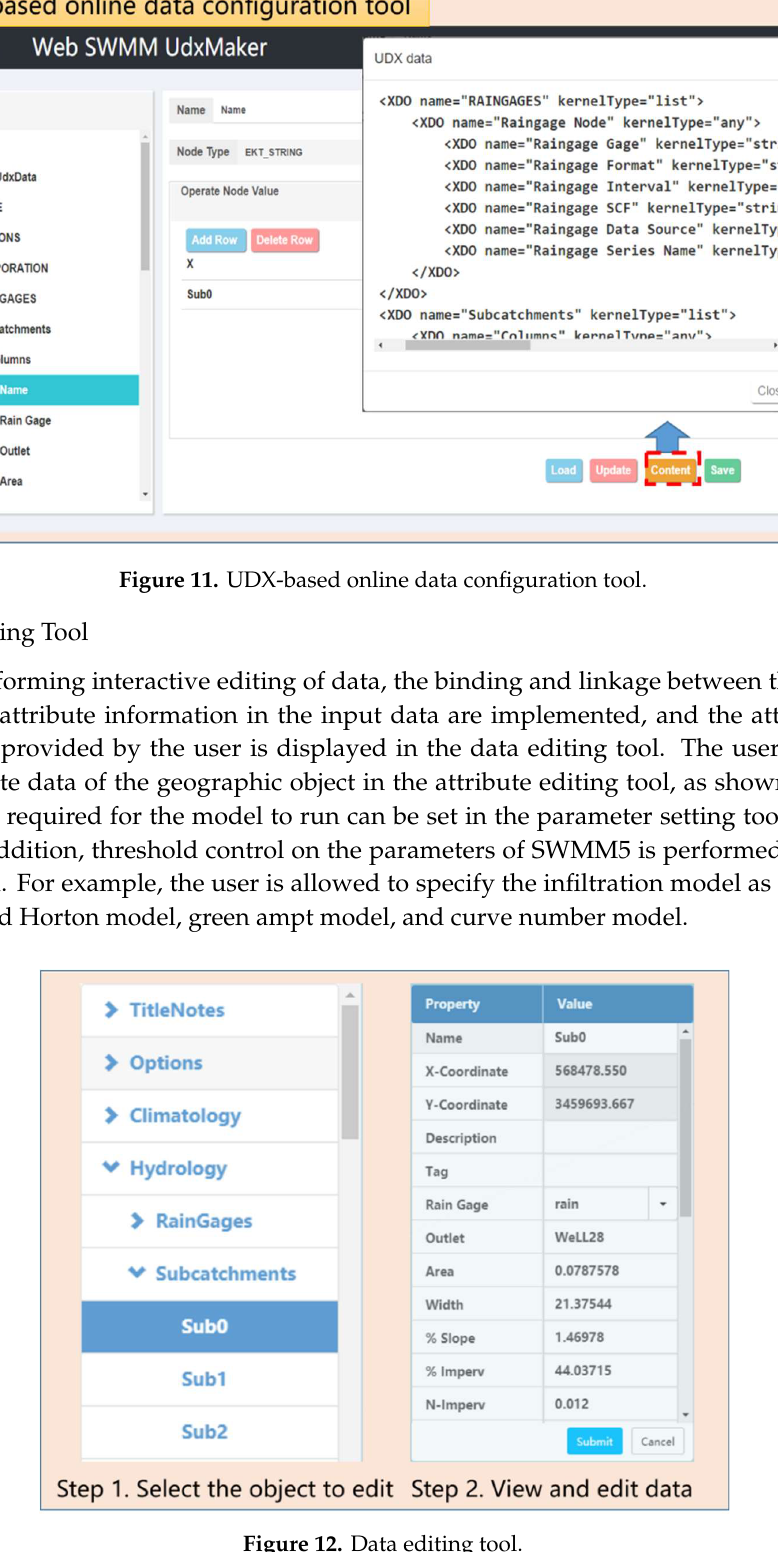
Figure 13. Parameter settings. 4.1.3. Data Visualization Tool Data visualization is divided into input data visualization and output data visualization. 1.